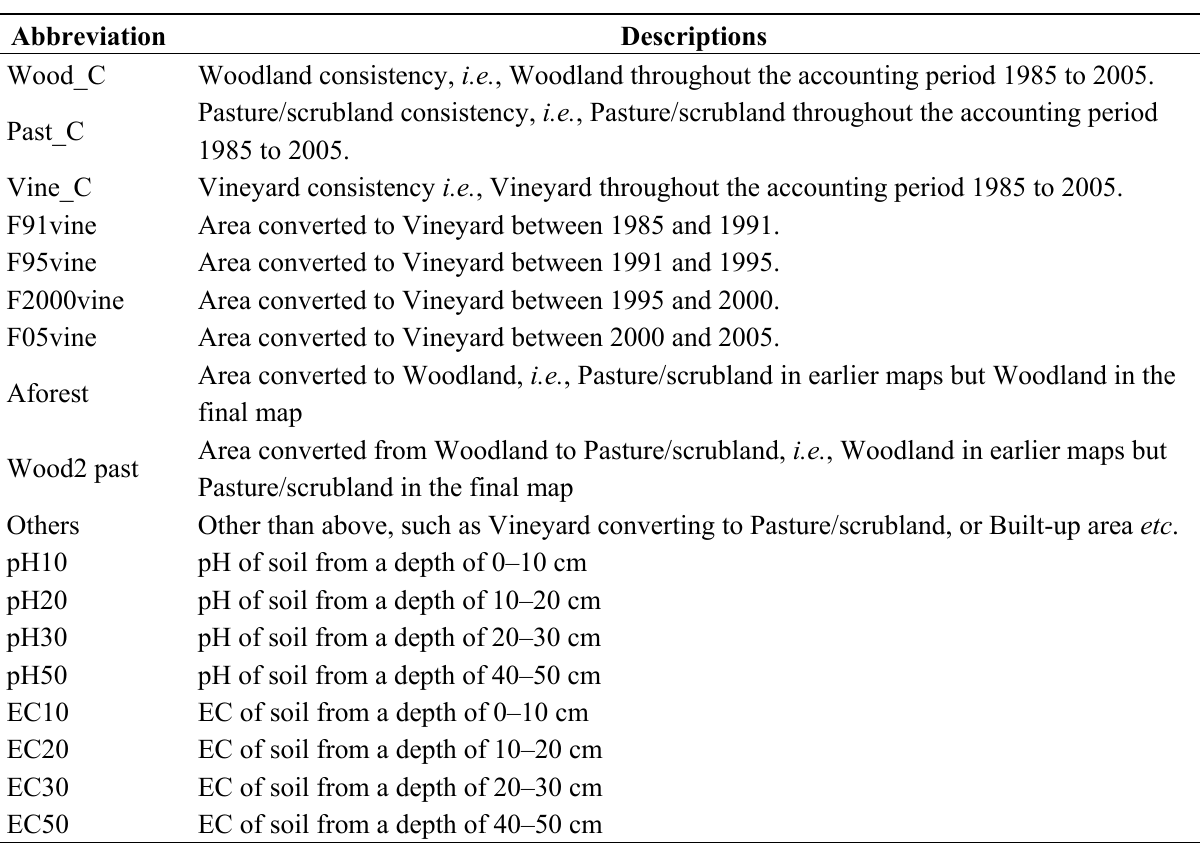
Table 1. Description of land use and land cover (LULC)